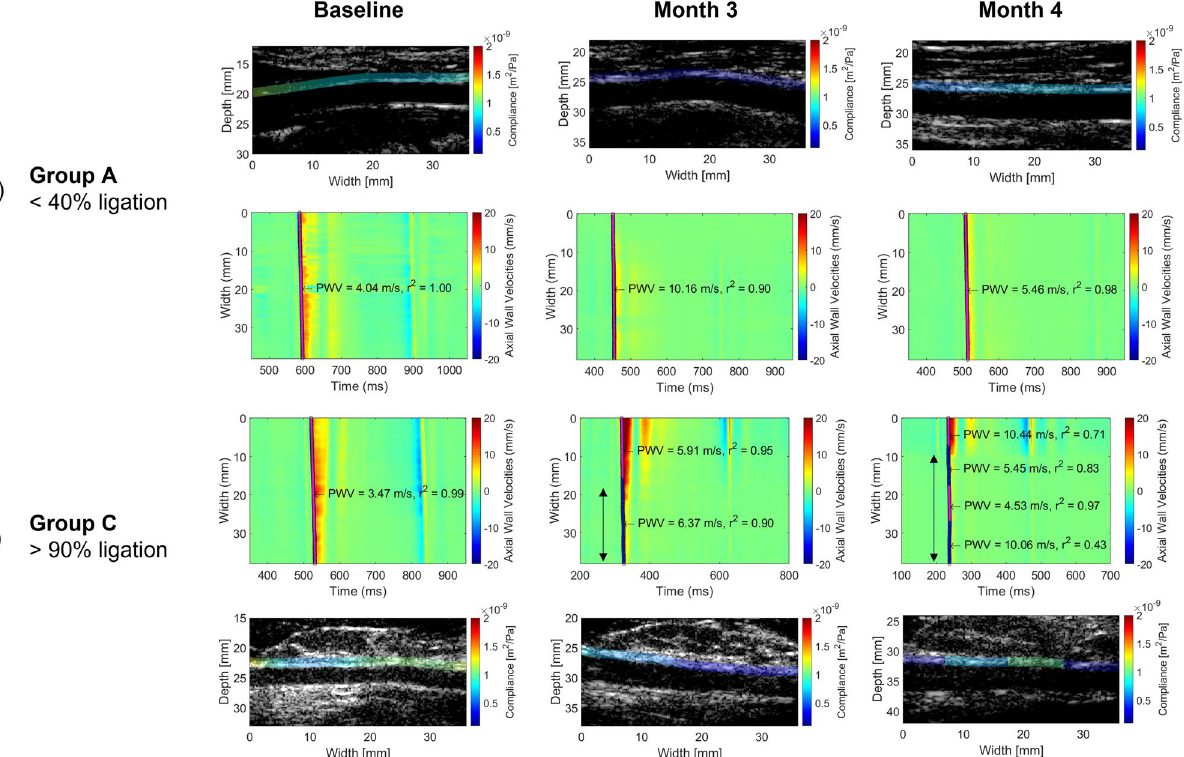
Figure 5. A qualitative example of remodeling over the course of the study and its impact on the spatiotemporal map for group A ( a ) and group C ( b ). The y-axis corresponds to the position in the vessel, whereas the x-axis corresponds to the time. ( a ) A homogenous reduction in wall motion can be observed, combined with an increase in PWV at months 3 and 4 compared to baseline. ( b ) An increased region of reduced wall motion can be observed in the same field of view, indicating a progressive change. At 3–4 months, multiple segments are detected, indicating inhomogeneous pulse wave propagation. A stiffer vessel can be observed after 3 months. After 4 months, the compliance values become more